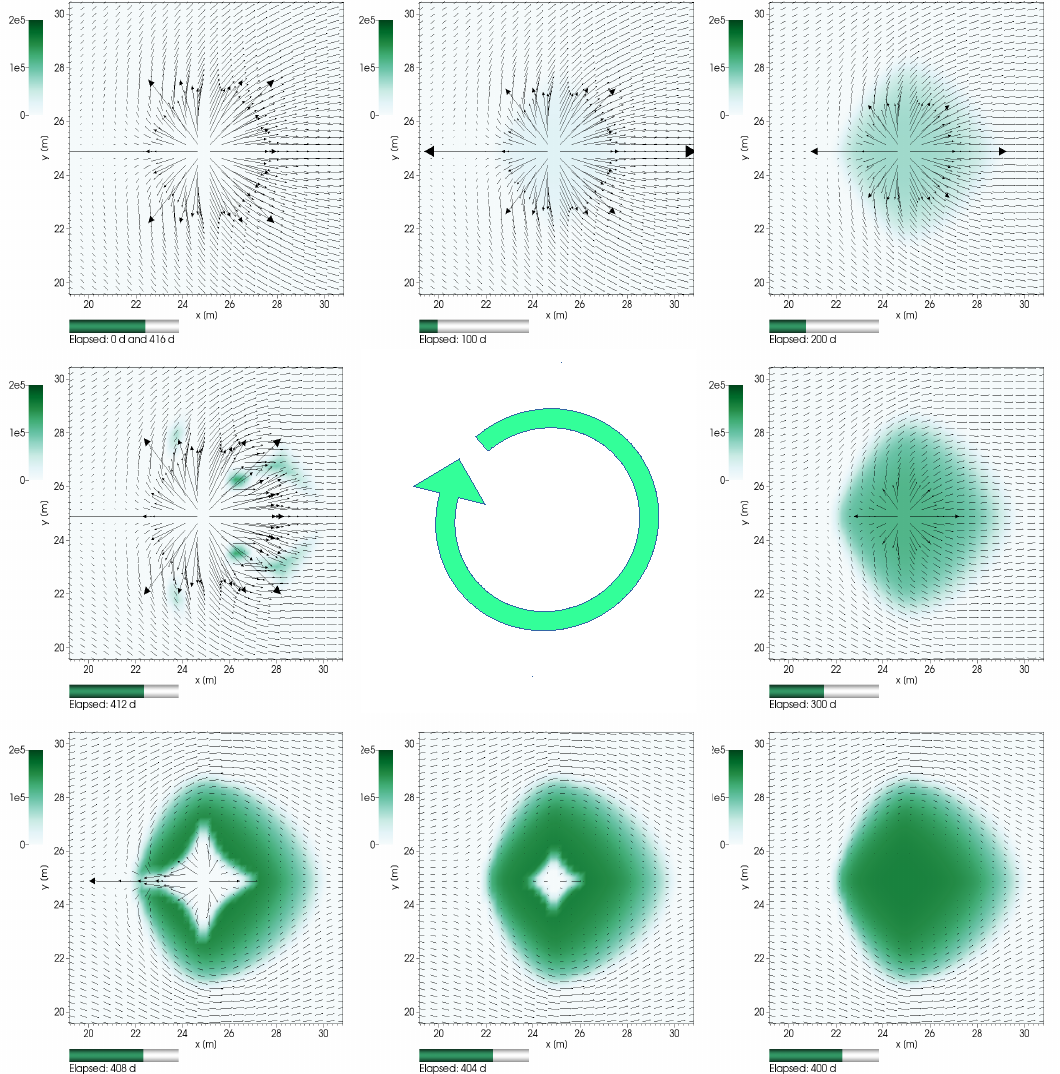
Figure 2. A sequence of snapshots of the cell-center groundwater seepage velocity fields and biomass concentration distributions in the example of Sect. 3.2. Velocity magnitude is indicated by arrow length and direction by arrow orientation; the arrow tails are located at the cell center; biomass concentration (gm − 3 ) is indicated by green intensity in each superimposed map. The initial condition snapshot is shown in the upper left corner, with time increasing in the clockwise direction, until the initial condition is reached again at day 416. The same scale is used in each